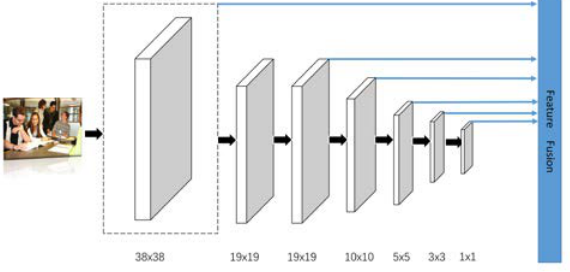
Fig. 3. Migration learning model.